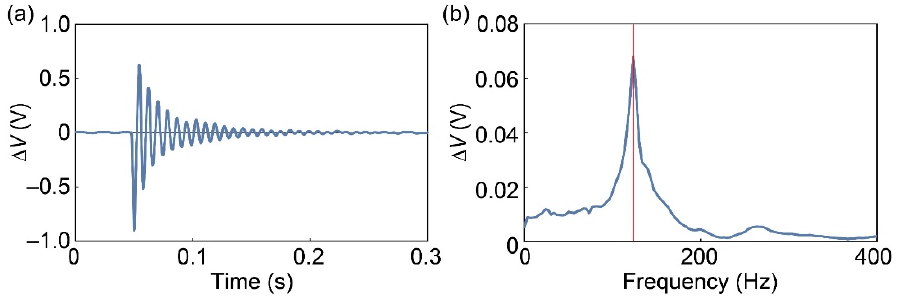
Figure 7. ( a ) Output voltage of sensor 1 when an impulse force is applied. ( b ) Measured resonance frequency.